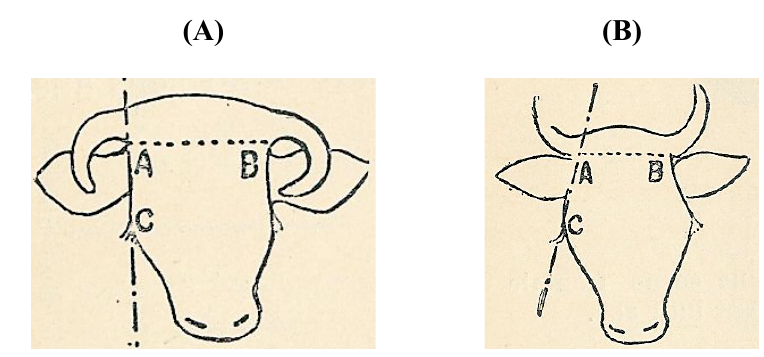
Figure 4. Basic types after Sanson [39] and Diffloth [40], ( A ) dolicocéphale : AC >